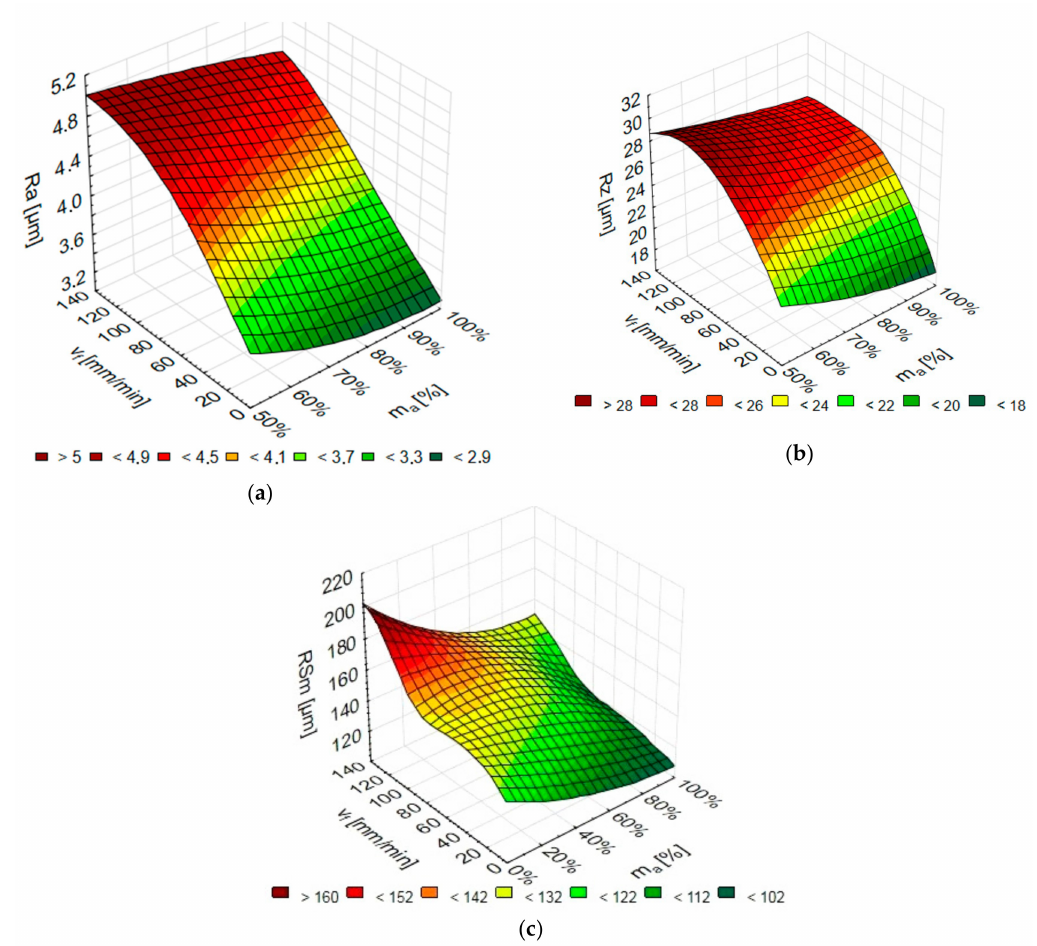
Figure 13. Numerical results of: ( a ) Ra, ( b ) Rz, ( c ) RSm depending on the jet feed velocity v f and abrasive flow rate m a (Ra: MLP 2-8-1, Rz: RBF 2-7-1, RSm: RBF 2-6-1).